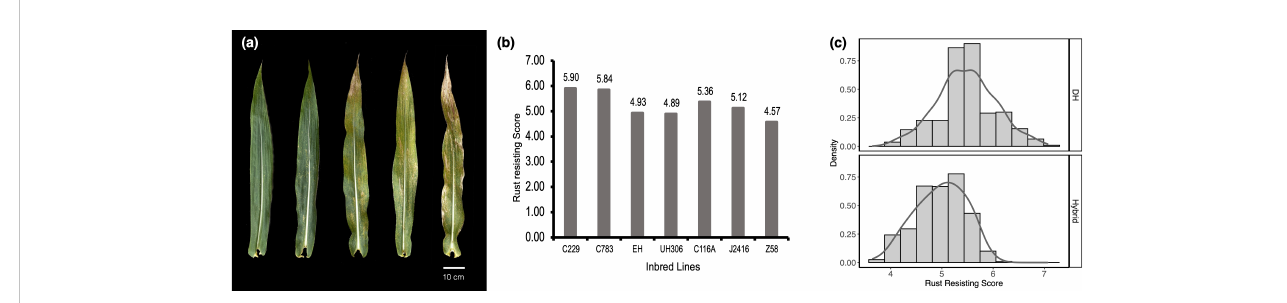
FIGURE 1 Southern Corn Rust Resistance Score (SCRRS) and its distribution. (A) The manifestation of susceptible leaves, the SCRRS of leaves were 9, 7, 5, 3, 1 from left to right. (B) the SCRRSs in DH founders and testers. (C) The distribution of SCRRS in DH (top) and hybrid (bottom) populations.